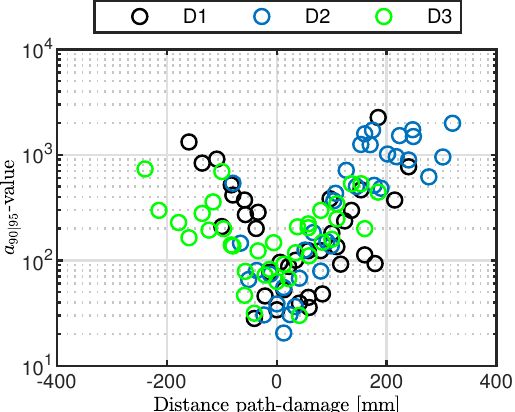
Figure 16. a 90 | 95 versus path distance from the flaw. The POD ( a ) is predicted along all paths crossing the